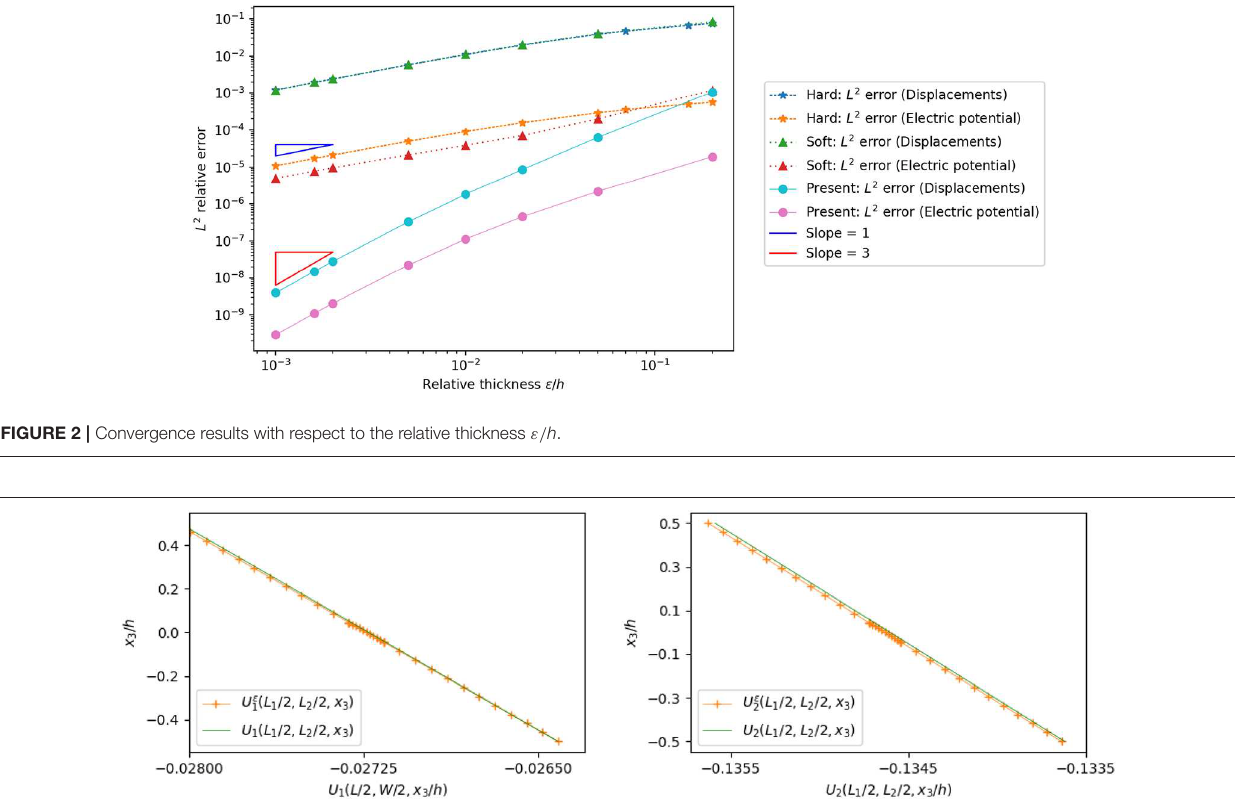
Frontiers in Materials |